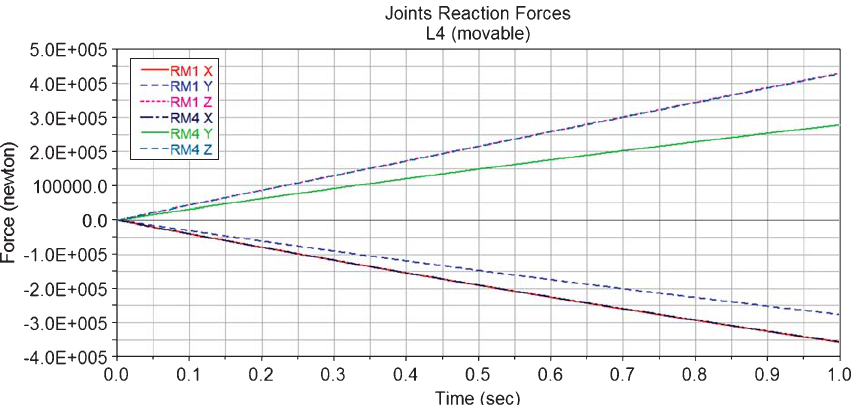
Fig. 15. Computed reaction forces at spherical joints that connects L4-A 4 , 1 and L4-A 4 , 4 .